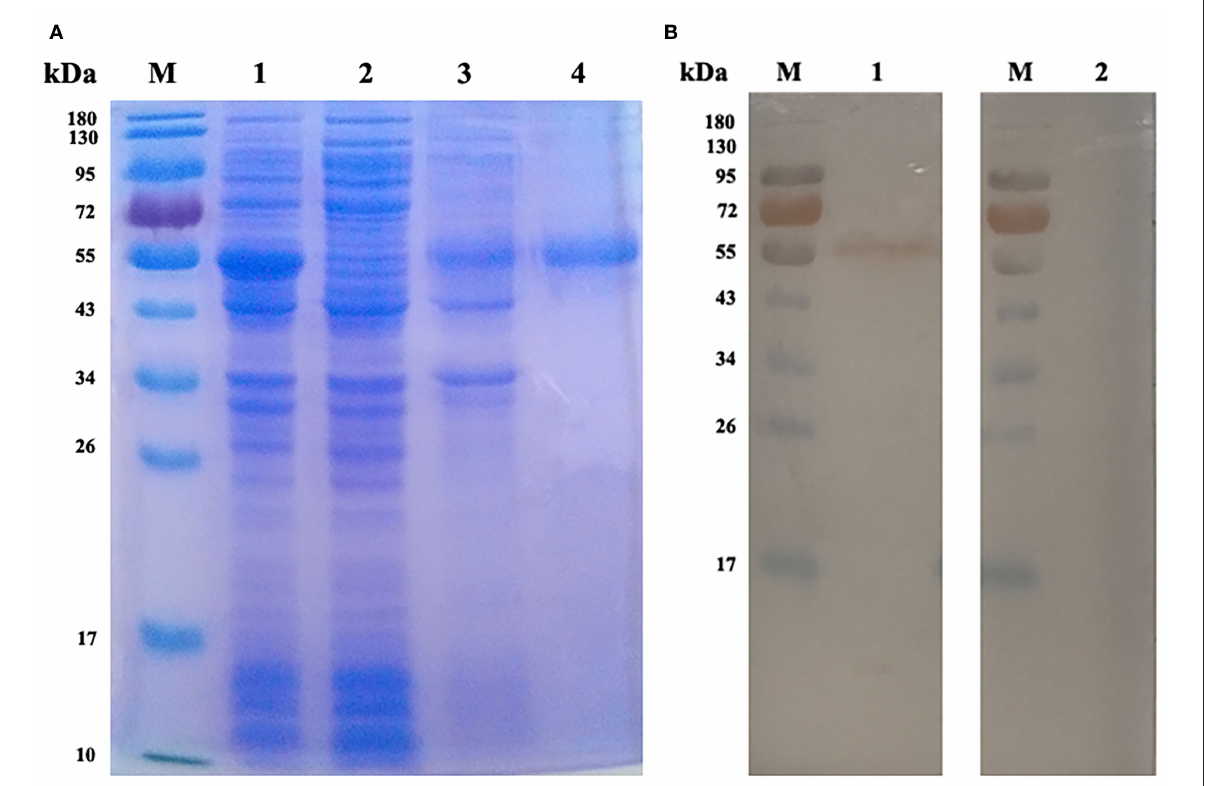
FIGURE2 Expression and Western blot analysis of rEmROM1. (A) Expression and purification of rEmROM1. M: protein standard molecular weight. Lane 1: pET-32a-EmROM1-transfected bacteria induced by IPTG for 5h. Lane 2: Cell lysate supernatant of pET-32a-EmROM1 bacterial liquid induced by IPTG for 5h. Lane 3: Cell lysate sediment of pET-32a-EmROM1 bacterial liquid. Lane 4: rEmROM1 after purification. (B) Western blot analysis of rEmROM1. M: protein standard molecular weight. Lane 1: Identification of rEmROM1 by E. maxima infected chicken serum. Lane 2: Recognition of rEmROM1 by negative chicken